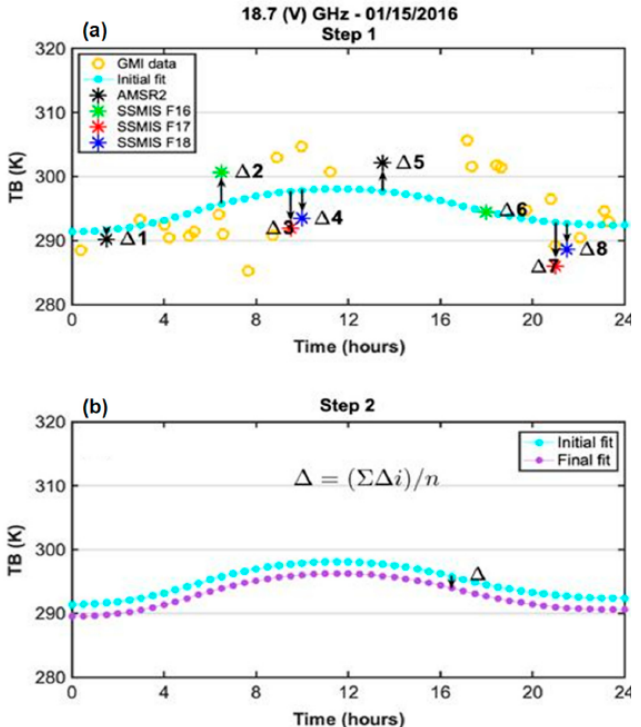
Figure 3. Schematic to compute diurnal cycle of PMW TBs for pixels between 68 ◦ S and 68 ◦ N, at a sample location (25.1 ◦ S and 138.6 ◦ E) with non-vegetated desert land cover for 15 January 2016 at 18.7 GHz vertical polarization ( a ) based on monthly GMI data, and ( b ) corrected by AMSR2 and SSMIS daily data. Time in each subplot is in local solar